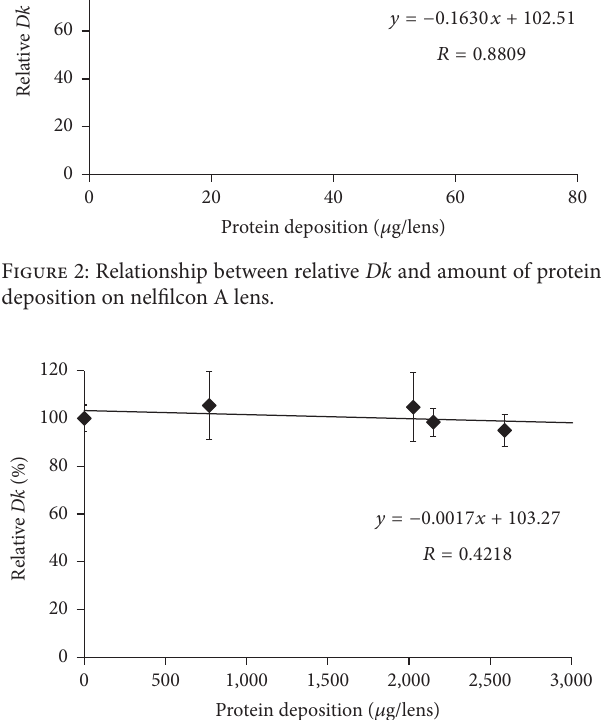
Figure 3: Relationship between relative Dk and amount of protein deposition on etafilcon A lens.